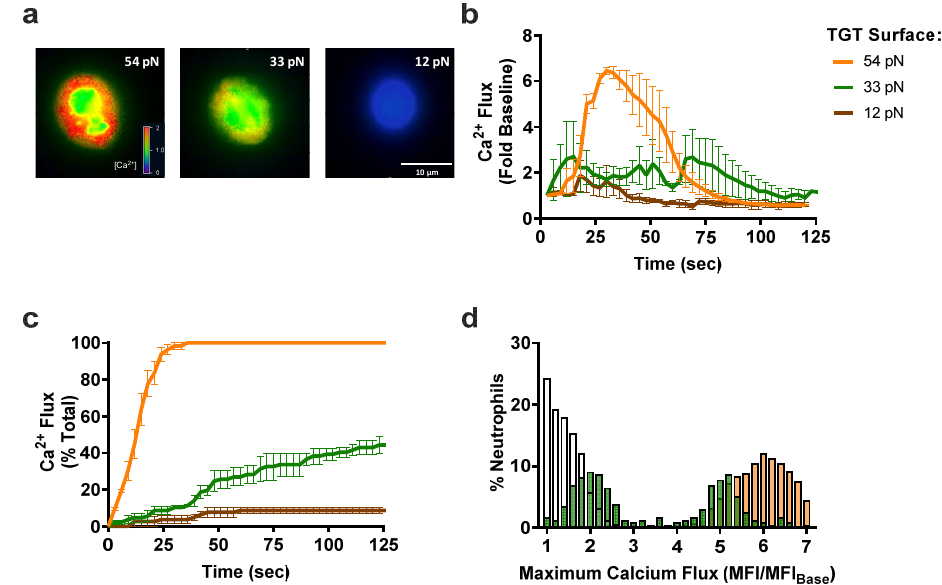
Figure 2. Neutrophil Ca 2+ flux amount and profile depend on the level of bond tension acting on HA β 2 -integrin. ( a ) Representative images of neutrophils sheared over TGT substrates functionalized with HA-inducing β 2 -integrin (CBR LFA1/2). Ca 2+ quantified using Fura-2. Scale bar shown as 10 µ m. ( b ) Ca 2+ flux over baseline (no shear) over time as shear stress is ramped from 0 to 1 dynes/cm 2 . Ca 2+ flux within neutrophil (fold over time 0) is reported as mean +/ − SEM over 7 fields of view with >10 cells per experiment ( n = 3, significance between 54pN and 33/12pN from 24–48 s, p < 0.01). ( c ) Percent of total neutrophils that exhibit flux in Ca 2+ over time, defined as >3-fold increase over baseline, when sheared over TGT functionalized with HA-inducing β 2 -integrin antibody (CBR LFA1/2). ( d ) Histogram of the amount of Ca 2+ flux over baseline that neutrophils exhibit when sheared over TGT functionalized with HA-inducing β 2 -integrin antibodies (binned every 0.2 MFI/MFI baseline ). Data are reported as mean +/- SEM over 7 fields of view with >10 cells per experi- ment ( n = 3).